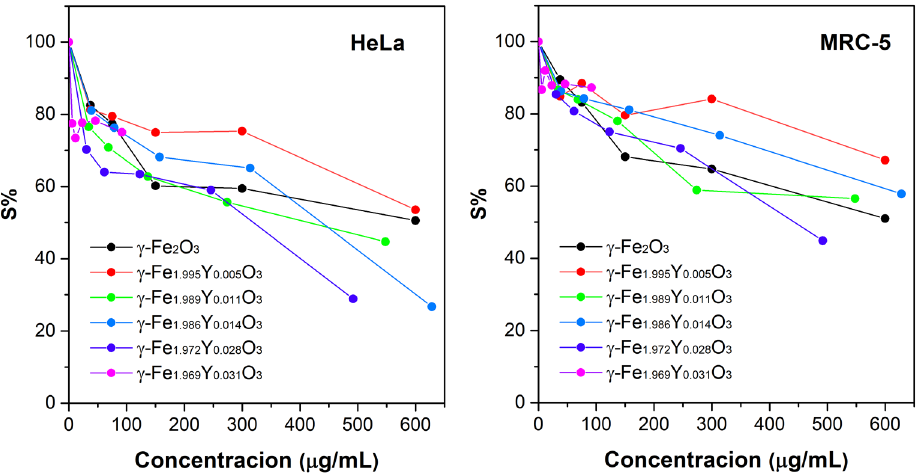
Figure 4. Survival of malignant HeLa and normal control MRC-5 cells, as determined by MTT test, after 72 h of continuous action of applied concentrations of YIONs. It is given as a function of different concentrations of investigated compounds. Table 2. IC 50 values of investigated nanoconstructs against cancer and normal cells. Chemical